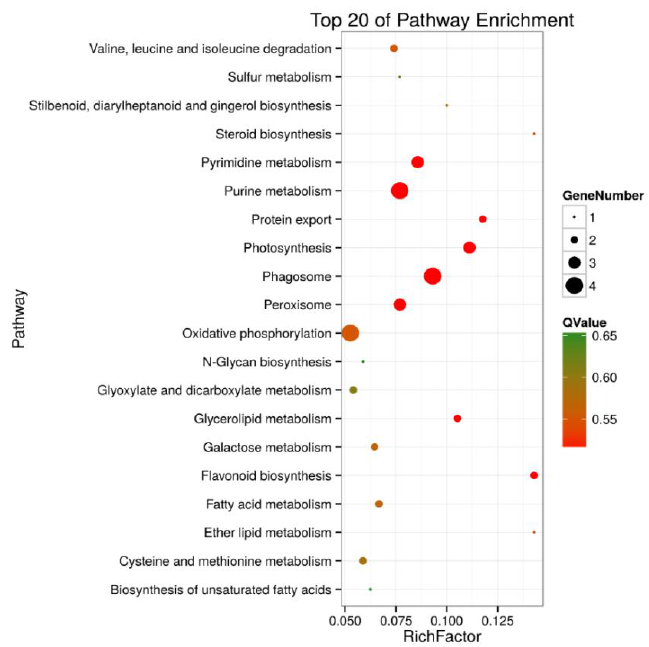
Figure 5. Top 20 pathway enrichments of DEPs in roots of salt-treated sugar beet plants compared with controlled plants. The Y -axis indicates the KEGG pathway, the X -axis indicates the rich factor. The dot size indicates the number of DEPs of the pathway, and the dot color indicates the Q -value. Rich factor indicates the number of differentially abundant proteins participating in a KEGG pathway as a proportion of proteins involved in the pathway in all identified proteins. A P -value less than 0.05 was defined as statistically significant.